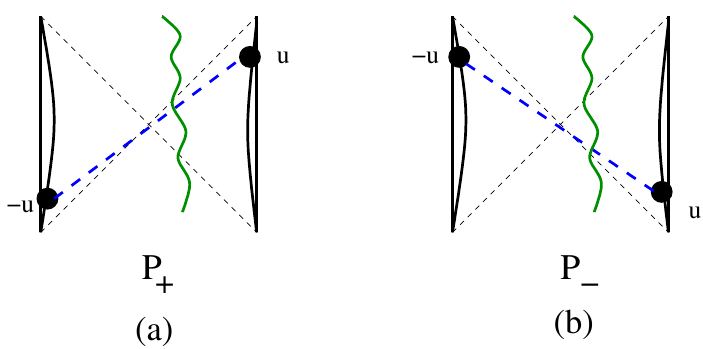
Figure 8 . (a) In order to measure P + we can consider a correlator in this con(cid:12)guration with large u , but smaller than the scrambling time. (b) To measure P (cid:0) we consider instead a correlator at these